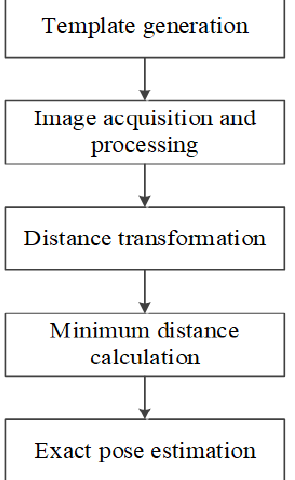
Figure 3. Flowchart of distance matching method.